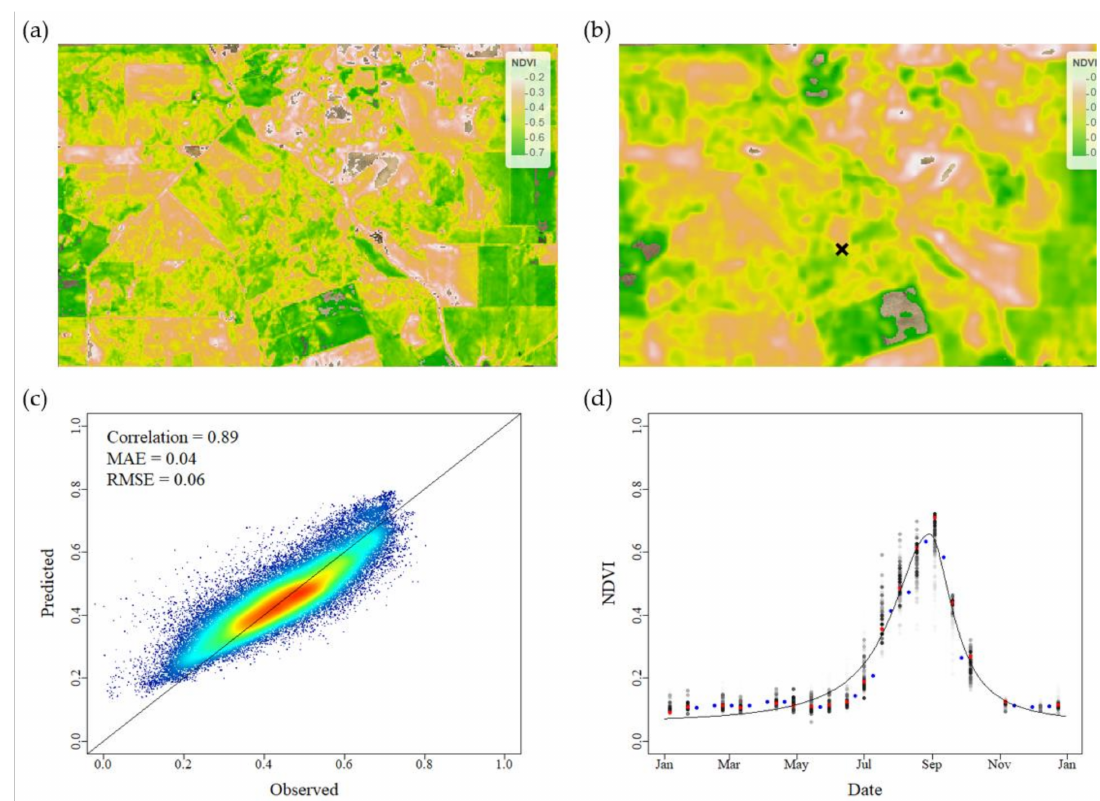
Figure 12. 2018-07-25 Landsat-8 test data: ( a ) observed NDVI; ( b ) predicted NDVI; ( c ) scatterplot of observed versus predicted NDVI coloured by density (red = high, blue = low) with overall accuracy statistics and ( d ) estimated annual growth curve for longitude 118.162, latitude − 31.268 marked by X in ( b ) with the spatially weighted Landsat-7 training data used to estimate the growth curves shown in shades of grey according to their spatial weight (white lowest and black highest, Landsat-7 data for the cell shown in red and Landsat-8 test data shown in